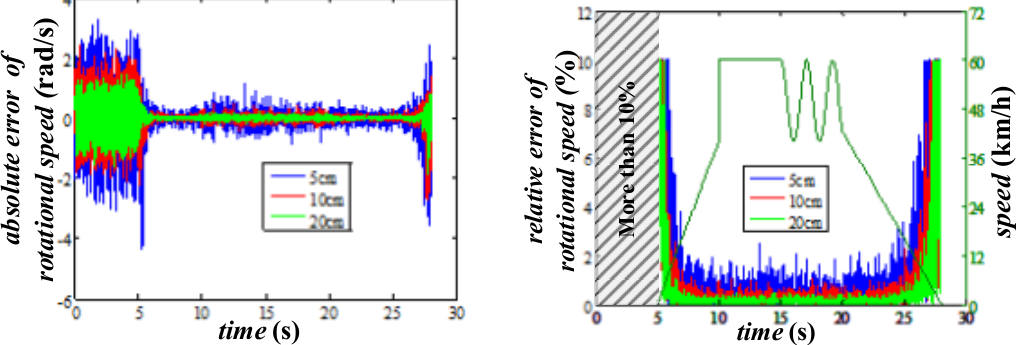
Figure 13. The evaluation error of rotational speed with different rotational radii.